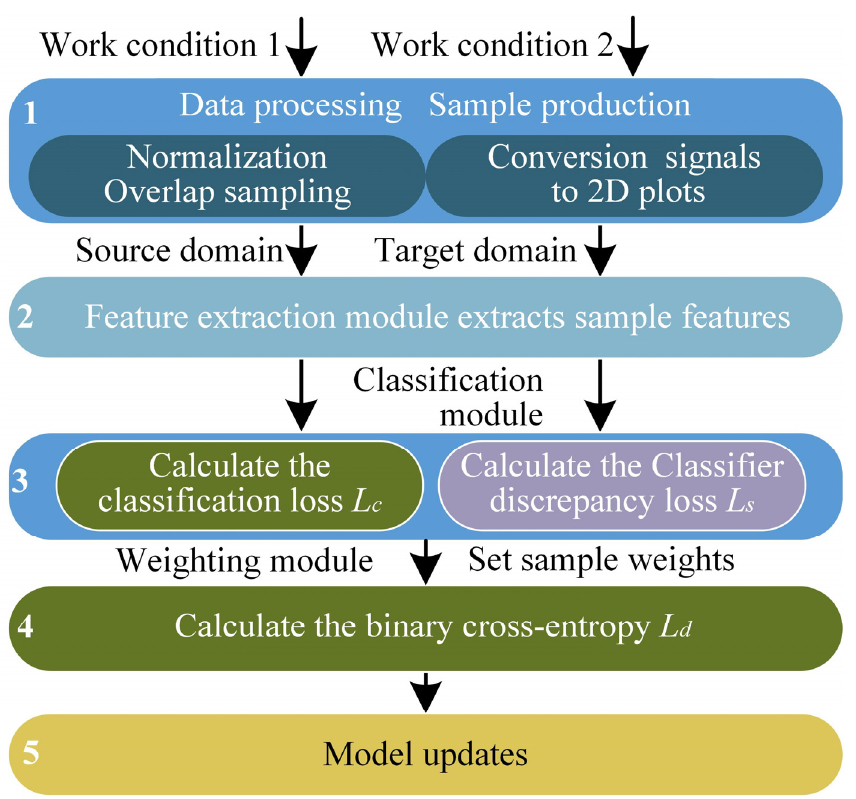
Figure 2. The framework of our